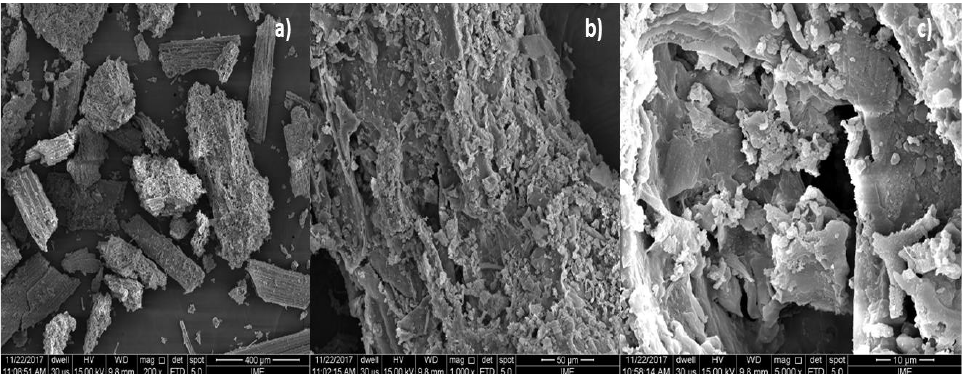
Figure 6. SEM of hydro-chars obtained by hydrothermal processing of corn stover at 250 ◦ C, a biomass/H 2 O ratio of 1:10 and 60 min (MAG: 200 × ( a ); MAG: 1000 × ( b ); MAG: 5000 × ( c